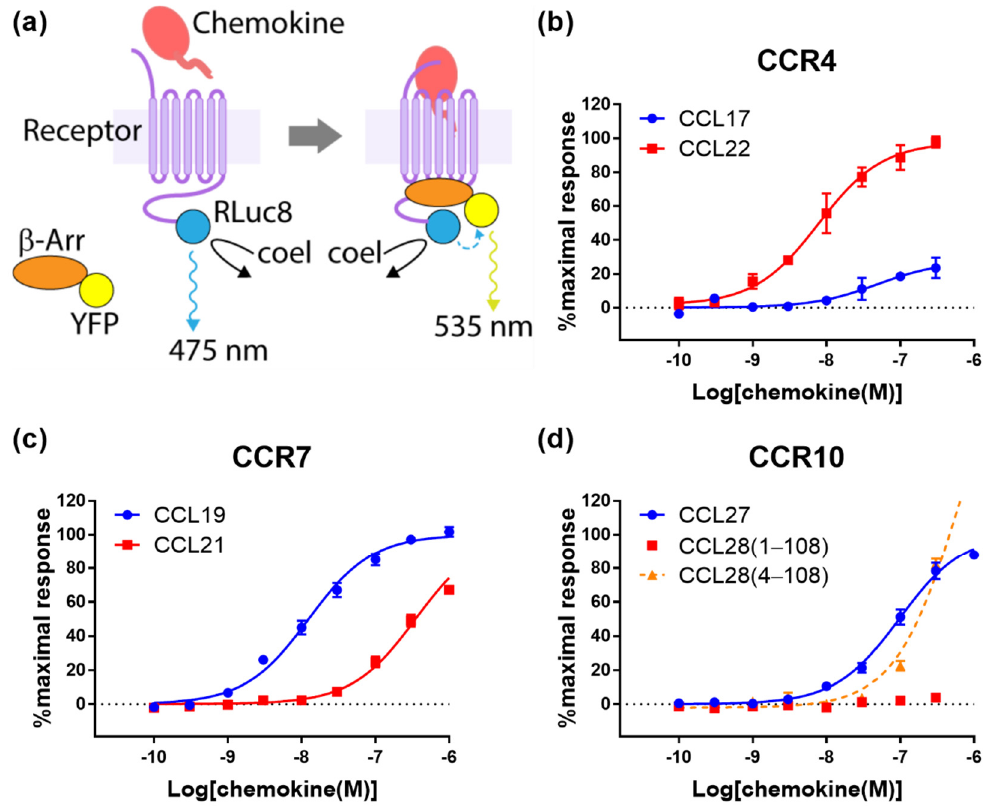
Figure 1. Chemokine ligands differentially stimulate β -arrestin recruitment to CCR4, CCR7 and CCR10. ( a ) The principle of the BRET-based β -arrestin recruitment assay. The Renilla luciferase (RLuc8) is fused at the C-termini of the receptors and the yellow fluorescent protein (YFP) tagged at the N-terminus of β -arrestin2 ( β -Arr). Upon activation by a chemokine agonist, YFP- β -arrestin2 is recruited to the receptor, bringing the YFP and RLuc8 into close proximity and enabling the resonance energy transfer after addition of the RLuc8 substrate coelenterazine h (coel). ( b – d ) Chemokine-induced β -arrestin recruitment at ( b ) CCR4, ( c ) CCR7, and ( d ) CCR10. A dashed line of best fit is shown in the case that the signal does not reach saturation. The presented data are mean ± SEM of at least three independent experiments, each performed in